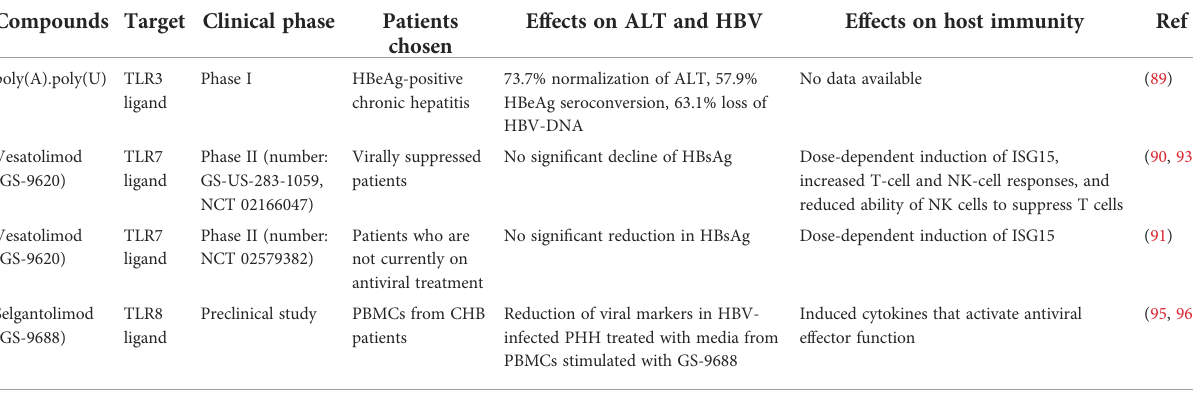
TABLE 1 TLR agonists in clinical